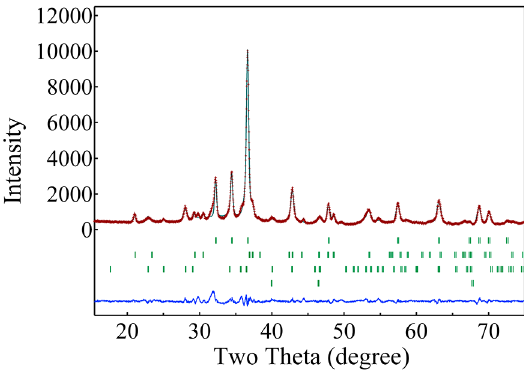
/ 4 Figure 7. Second dehydrogenation curves of the LiBH composite rehydrogenated at 450 ºC under 6 and 9 MPa hydrogen pressures,